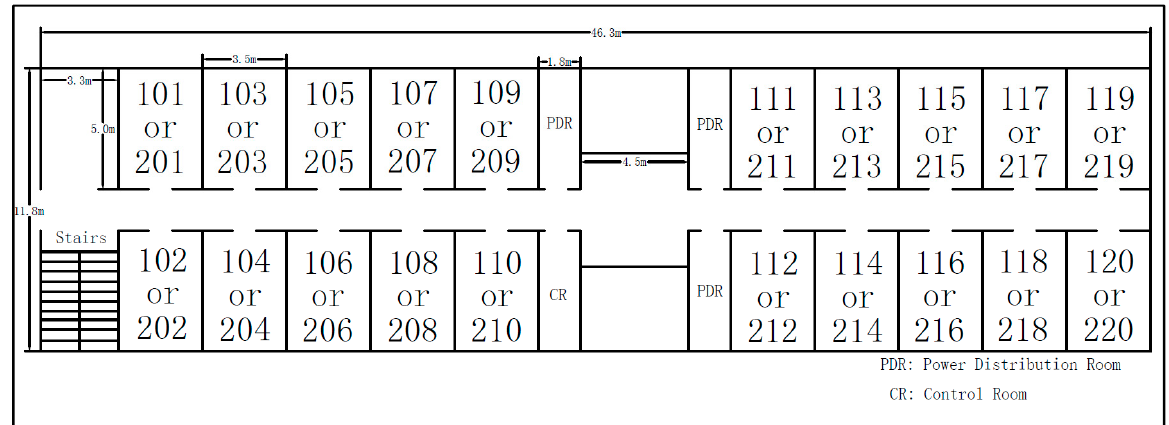
Figure 4. Layout of Yibei Building.